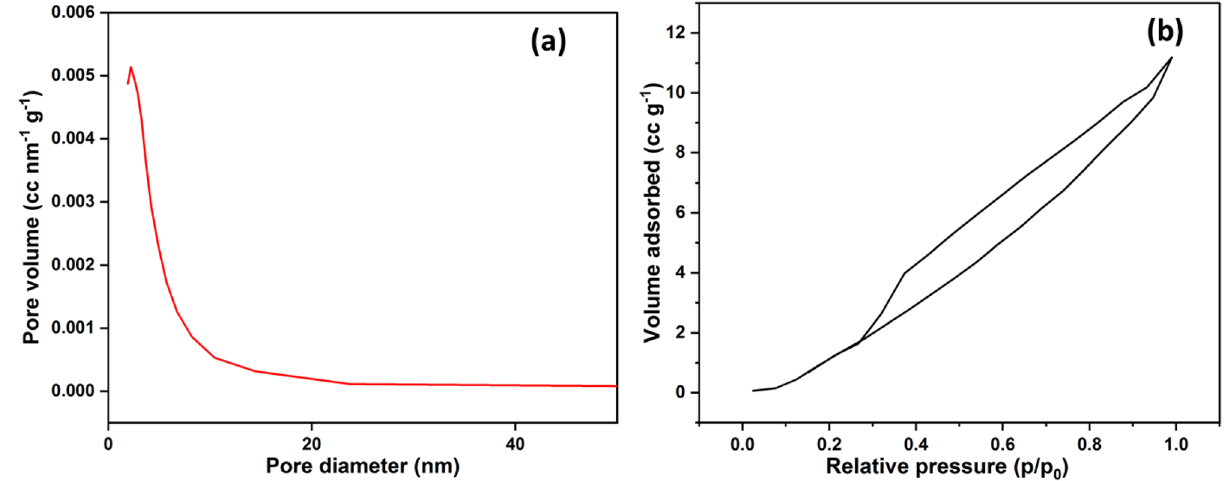
Figure 6. ( a ) BET and ( b ) N 2 adsorption–desorption curve of synthesized